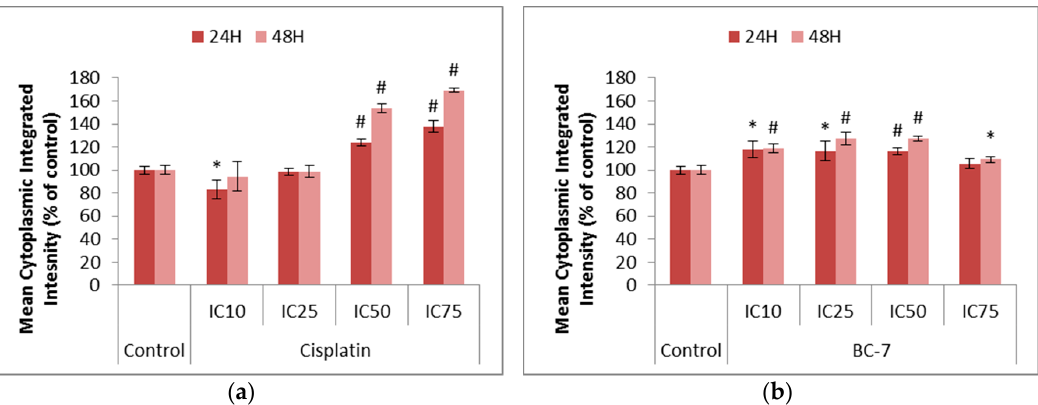
Figure 6. Changes in the levels of acidic organelles in HeLa cells after 24 and 48 h of treatment with ( a ) cisplatin and ( b ) BC-7. The LysoTracker™ Deep Red staining method was used. Control treatment refers to untreated control. Results displayed as mean cytoplasmic integrated intensity and expressed as a percentage of the untreated control. Error bars indicate SD of three individual experiments, each performed in quadruplicate ( n = 3). Significance was determined using the two-tailed student t -test: * p < 0.05 and # p < 0.005 compared to untreated control.